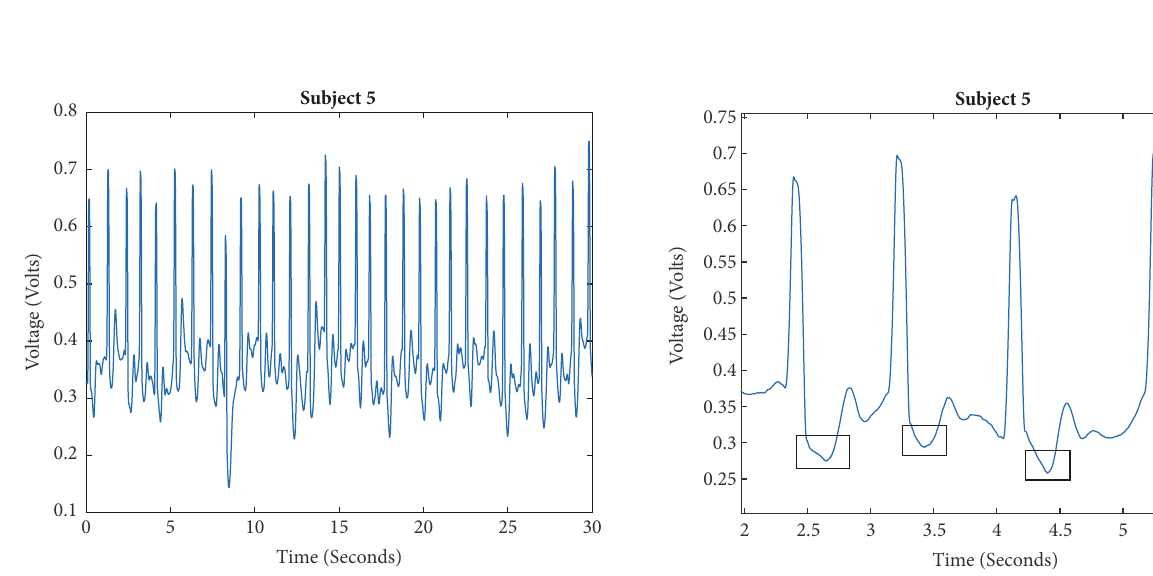
Figure 19: ECG signal of unhealthy subject 5.